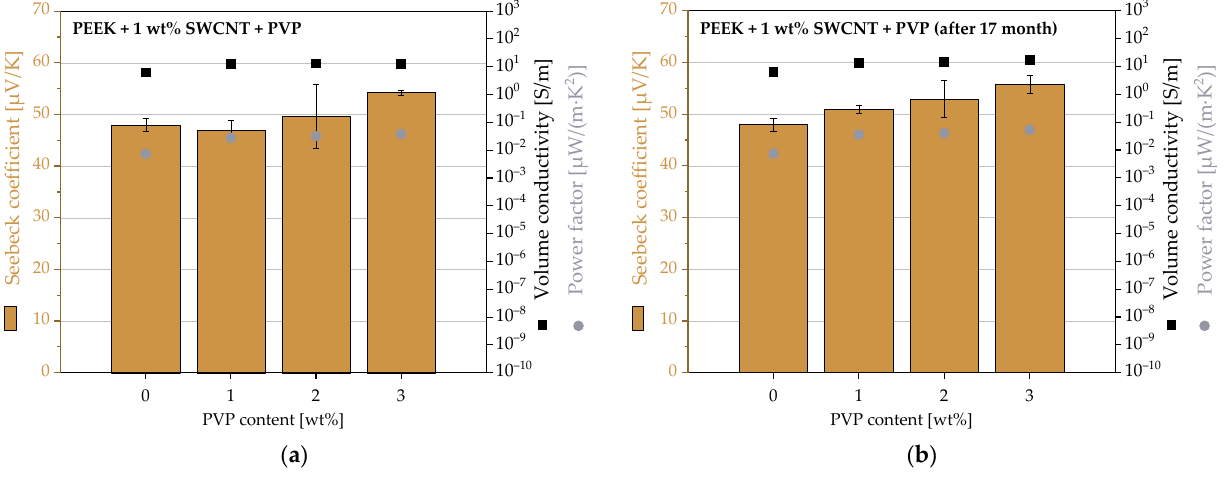
Figure 7. TE properties of PEEK composites with 1 wt% SWCNT Tuball and different contents of PVP, first measurements ( a ), and measurement repeated after 17 months ( b ).